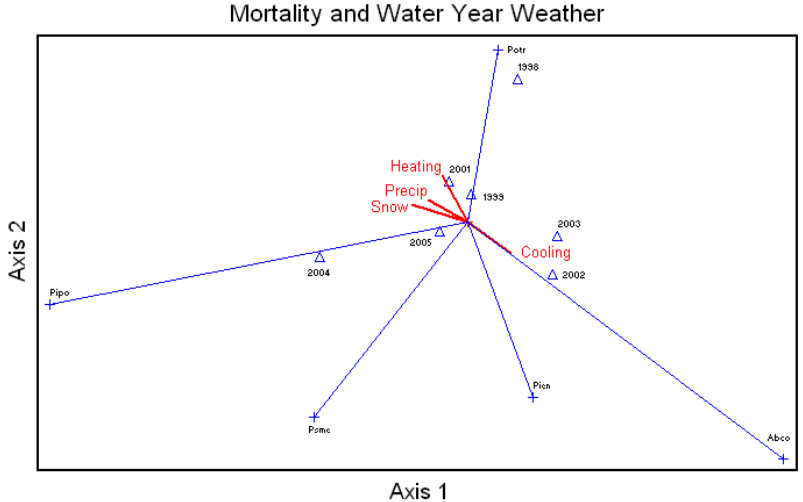
Figure 5. Canonical Correspondence Analysis Ordination for average percent mortality of all the species by year and correlated to the water year snow (Snow) and rainfall (Precip) and the number of heating (Heating) and cooling (Cooling) degree days., Abco = Abies concolor , Pipo = Pinus ponderosa , Potr = Populus tremuloides , Psme = Pseudotsuga menziesii , Pien = Picea engelmannii . Average percent mortality of unthinned ponderosa pine size classes was correlated to the annual (calendar year) snow, rainfall, and average daily maximum and minimum temperatures (Figure 6), and the mortality in the larger size classes was highly related to rainfall and snow. The three smallest size classes showed some relationship with maximum temperature.